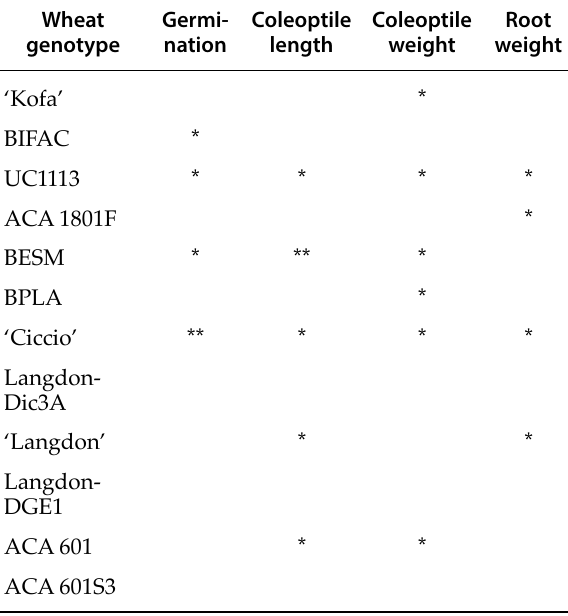
Table 2. Mean comparisons between Fusarium graminear- um inoculated and control (water) plates of four seedling variables across three experiments for 12 wheat